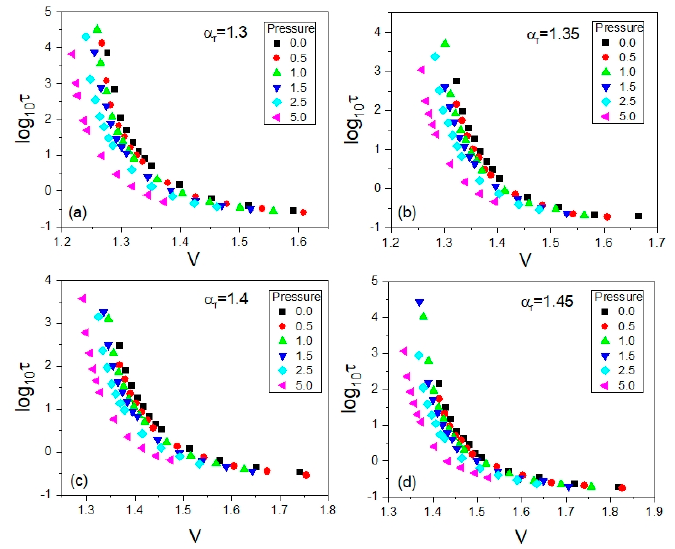
Figure A1. Plots of the isobaric dependences of translational relaxation times τ on the particle number volume V for different anisotropy aspect ratios α r in the supercooled liquid state in the GB model. In the separate panels, there are the cases shown for the different anisotropy aspect ratios α r : ( a ) 1.30, ( b ) 1.35, ( c ) 1.40, and ( d ) 1.45,